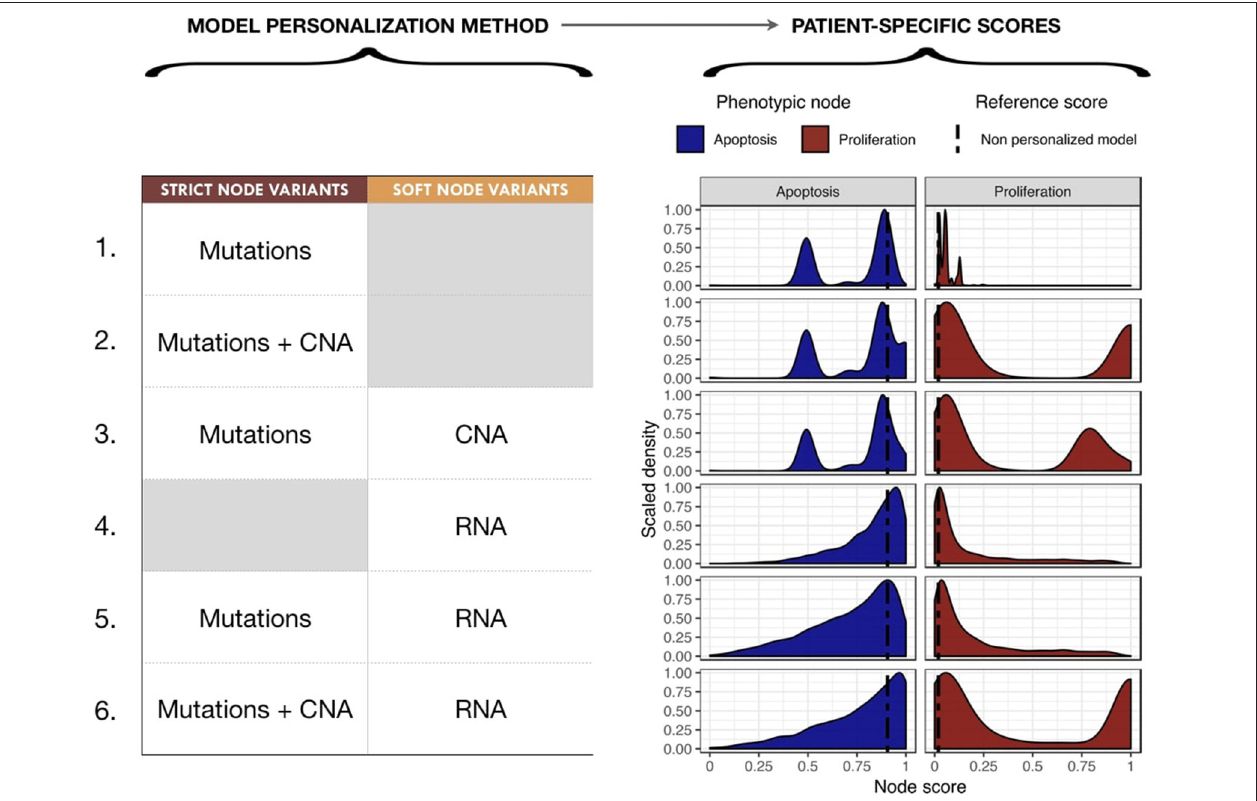
FIGURE 6 | Impact of different model personalization methods on the distribution of phenotypic nodes Proliferation and Apoptosis , using a generic cancer model and METABRIC data. On the left, description of data types used as Strict or Soft Node Variants to personalize the model resulting in different phenotypic probabilities’ distributions across the cohort, as shown on the right. Dashed lines correspond to the probabilities of the phenotypes obtained from the original model without any personalization: 0.019 for Proliferation and 0.906 for Apoptosis